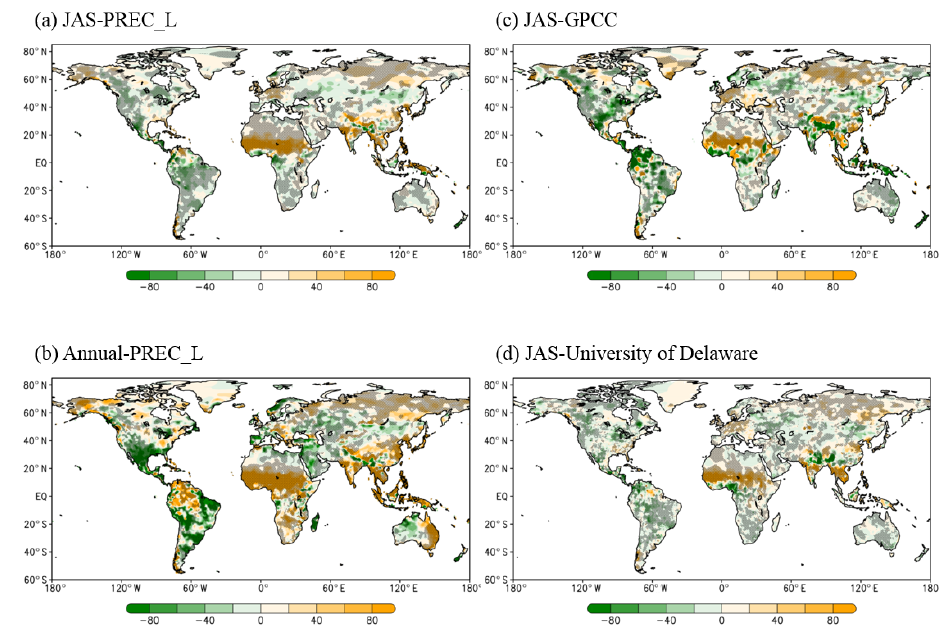
Figure 3. Global maps of the trend shift for (a) JAS precipitation PREC_L (mm10 years − 1 ) , (b) annual precipitation, (c) JAS precipitation GPCC, and (d) JAS precipitation – University of Delaware. Shading denotes δ tan θ . Hatching represents areas where trends changed sign between the two parts of the study period (tan θ 1 · tan θ 2 <0).